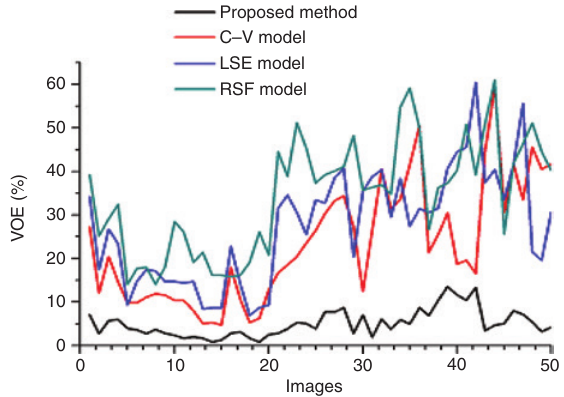
Figure 8: Comparison of Results Using VOE for MRI Scan